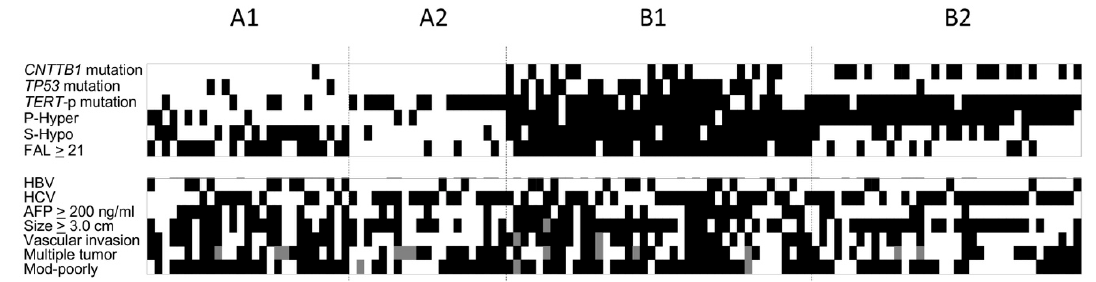
Figure 2. Heat-map of the molecular alterations and clinical background of the cases in each subclass. The black rectangle represents positive, the white represents absence, and gray shows that information is missing. p -hyper denotes promoter hypermethylation determined by methylation levels of 8 tumor suppressor genes, and S-hypo denotes significant global hypomethylation determined by methylation levels of 3 kinds of repetitive DNA sequences. TERT -p mutation, TERT promoter mutation. FAL: fractional allelic loss (%) as a representative of the degree of chromosomal alterations. Mod-poorly: moderately-poorly differentiated. Table 3. Classification of HCCs based on the molecular alterations and clinical feature.